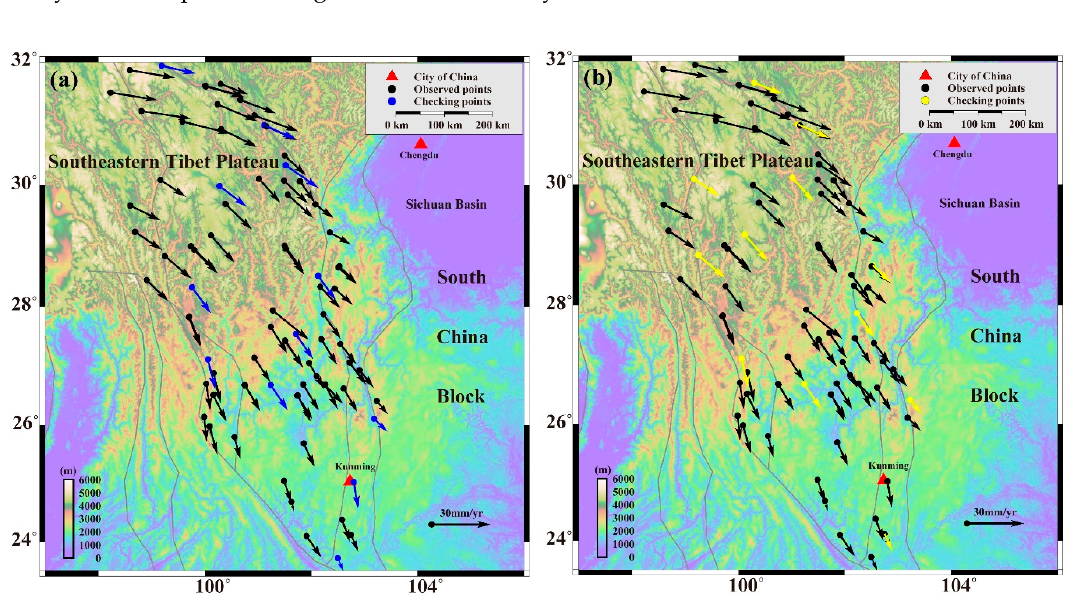
Table 3. RMS of the fitting points and checking points using four algorithms (Experiment 2).